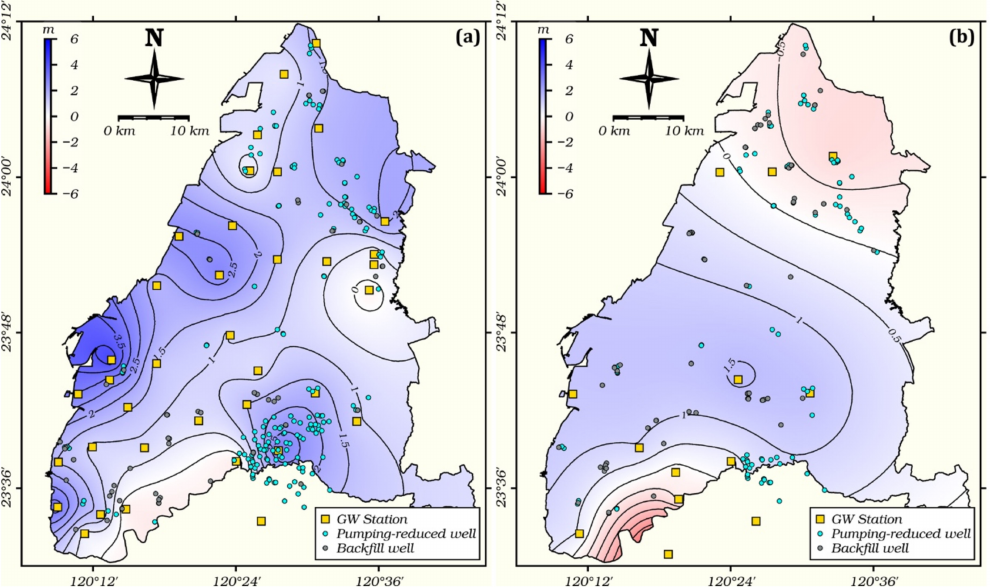
Figure 11. Changes in groundwater levels (levels in April 2019 minus levels in April 2011) at 0.5 m intervals in ( a ) aquifer 3 and ( b ) aquifer